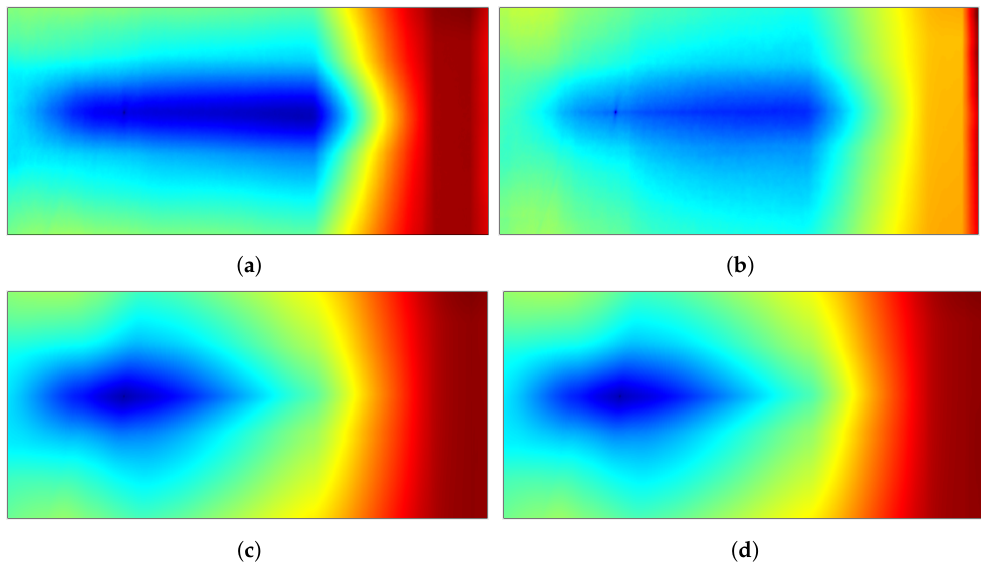
Figure 5. Loss in HSV over the image used for experiment 1. Blue indicates no loss and dark red the maximum loss: ( a ) hue; ( b ) saturation; ( c ) lightness; ( d ) HSV.